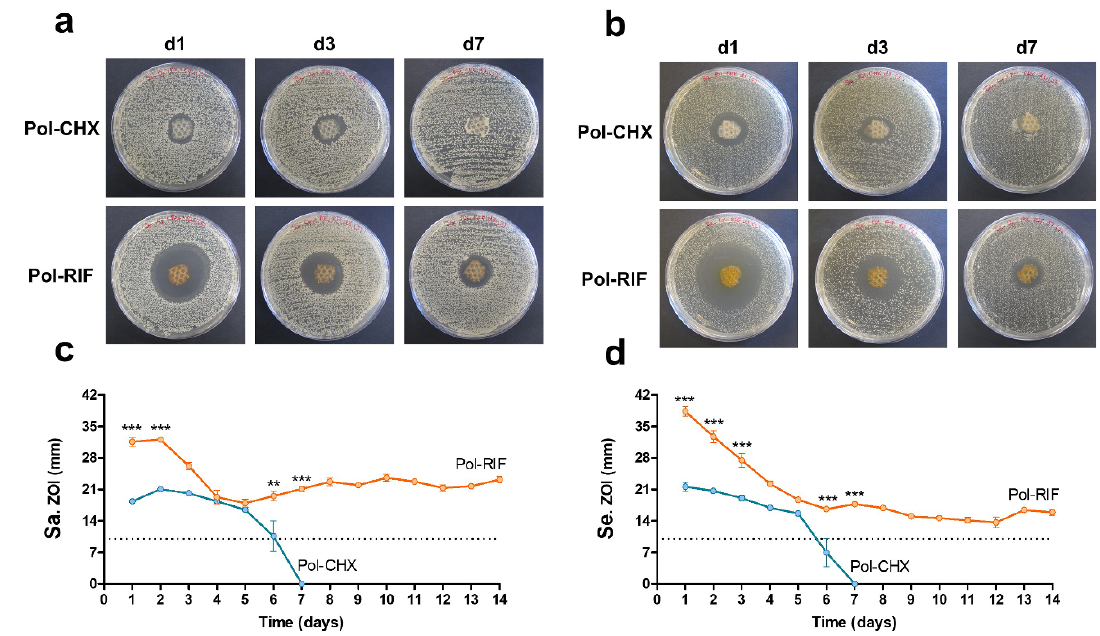
Figure 5. Antibacterial activity over time. Upper panel: Macroscopic pictures of the zones of inhibition (ZOIs) developed by Pol-CHX and Pol-RIF coated meshes at days 1, 3, and 7 of the initial inoculation with ( a ) Sa and ( b ) Se. Lower panel: Representation of the 24-h variation of the ZOIs amplitude of Pol-CHX and Pol-RIF coated meshes challenged with ( c ) Sa and ( d ) Se (** p < 0.01; *** p < 0.001). The length of the mesh fragments is depicted (dashed lines).